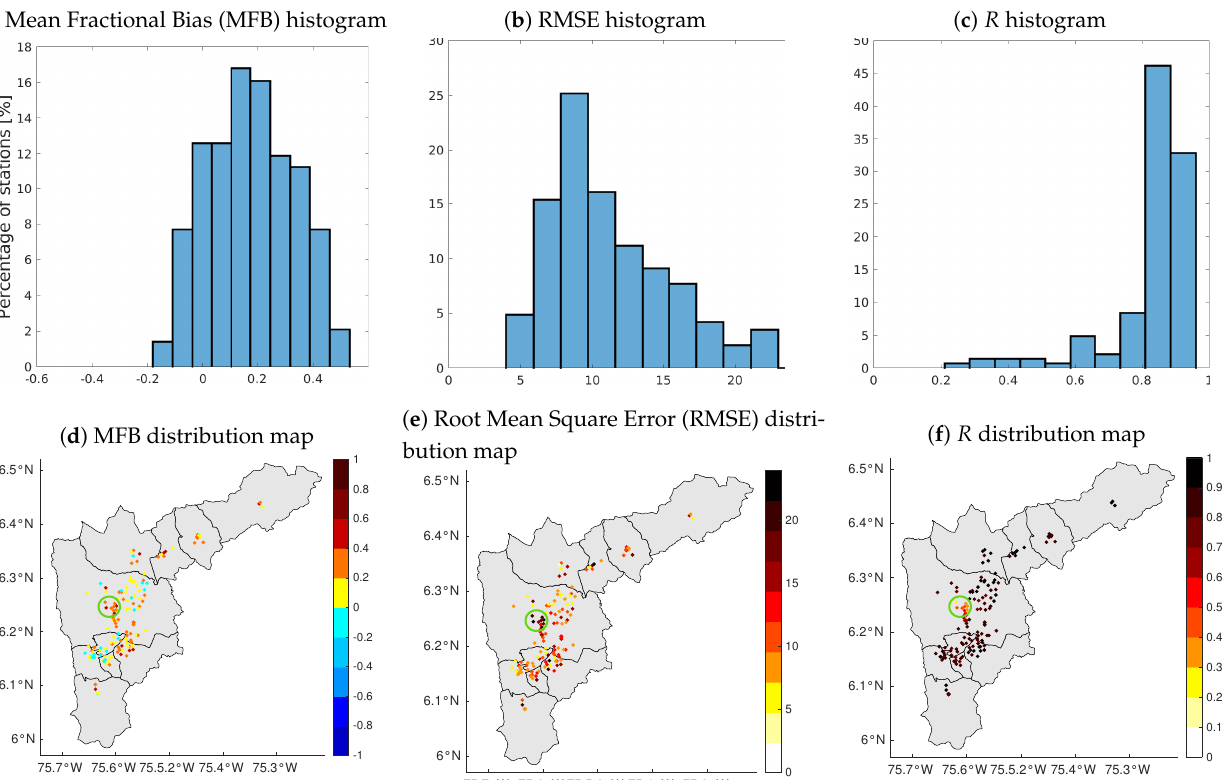
Figure 5. Evaluation of low-costs network against the official monitoring network for the period between 25 February 2019 and 15 March 2019. Panels ( a – c ) show the histograms of the MFB, RMSE and R respectively. Panels ( d – f ) show the MFB, RMSE and R values of each evaluated sensor.